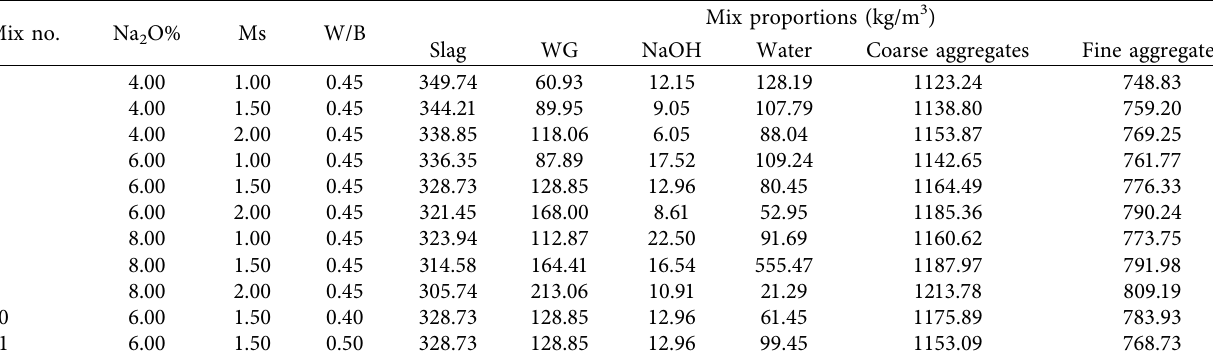
Table 5: Mix proportions of concrete.